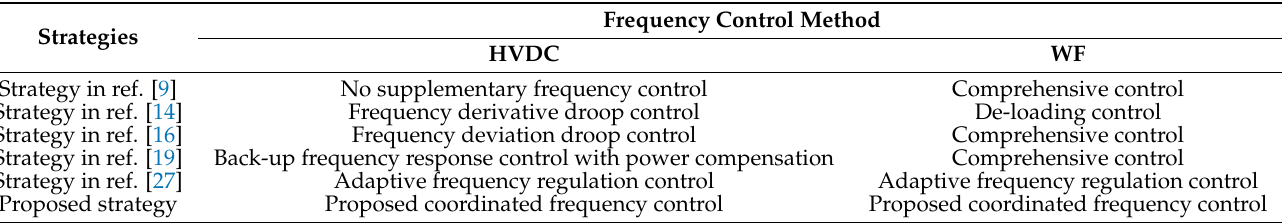
Table 9. Simulation results of different control strategies based on the operating conditions of Case 1 and Case 2. Operation